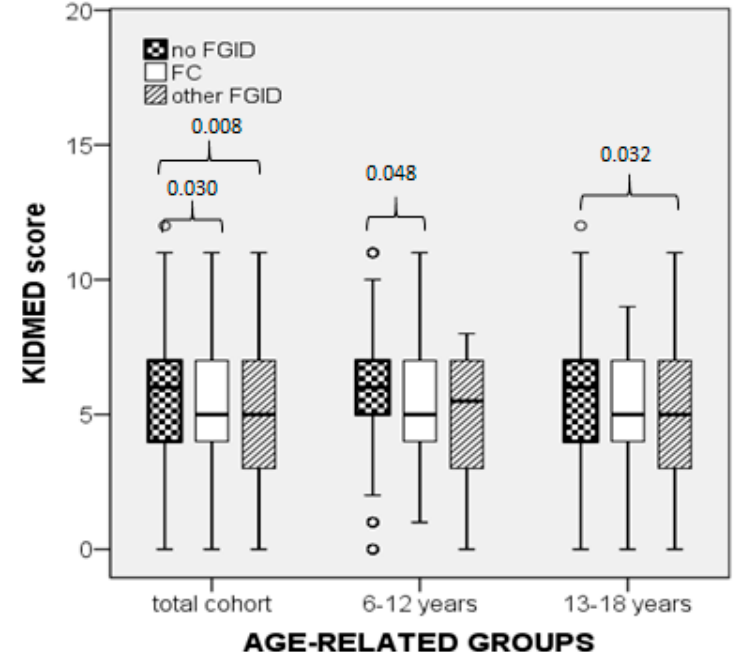
Figure 2. Comparisons of KIDMED score between participants without functional gastrointestinal disorders (FGIDs) and those with either functional constipation (FC) or other FGIDs, in the cohort and the two age-subgroups (Mann–Whitney U test).